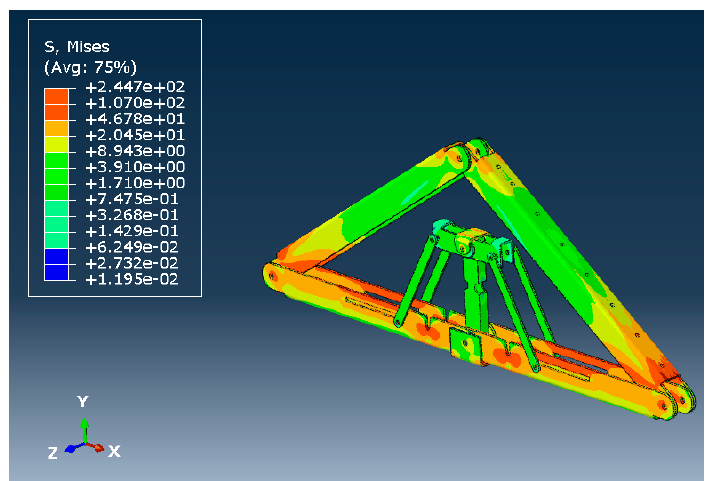
Figure 27. Von Misses stress (MPa) of the Apex connection (factored gravity load of 4 kPa).